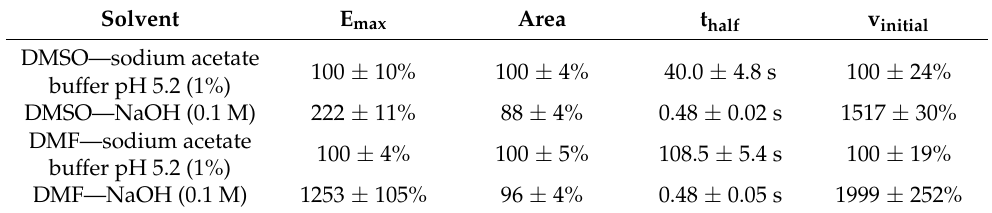
Table 3. Light-emission maximum (E max , in RLU), calculated area of light-emission (area, in RLU), light-emission half-life (t half , in s) and initial velocities (v initial , in RLU s − 1 ), for the CL reactions of Br2-Cla in DMSO and DMF, at either at basic (NaOH, 0.1 M) or acidic pH (sodium acetate buffer pH 5.2, 1%). Measurements were performed in solutions with a final concentration of the compounds of 0.73 µ M. Values are presented in percentage (%), with the results obtained in the presence of sodium acetate buffer pH 5.12 (1%) being the reference for both solvents. Solvent E max Area t half v initial DMSO—sodium acetate 100 ± 10% 100 ± 4% 40.0 ± 4.8 s 100 ± 24% buffer pH 5.2 (1%) DMSO—NaOH (0.1 M) 222 ± 11% 88 ± 4% 0.48 ± 0.02 s 1517 ± 30% DMF—sodium acetate 100 ± 4% 100 ± 5% 108.5 ± 5.4 s 100 ± 19% buffer pH 5.2 (1%) DMF—NaOH (0.1 M) 1253 ± 105% 96 ± 4% 0.48 ± 0.05 s 1999 ±